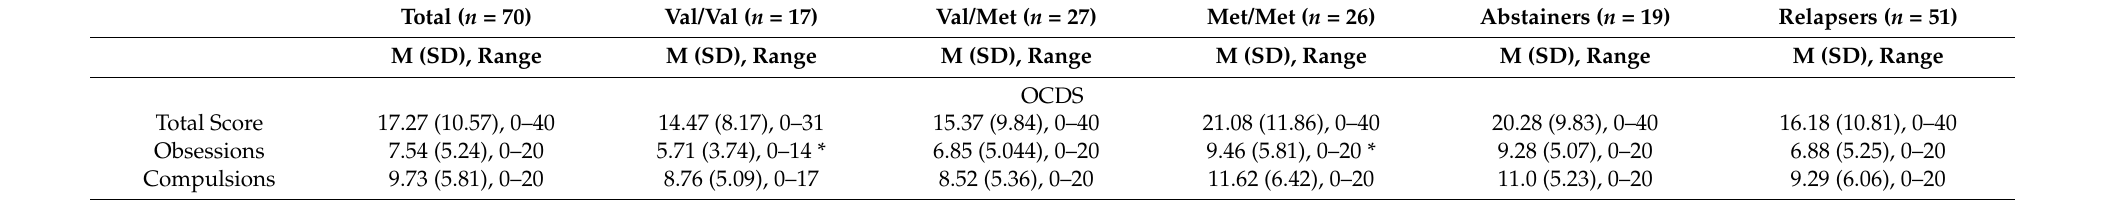
Table 3. Obsessive Compulsive Drinking Scale (OCDS) by genotype and relapse status.